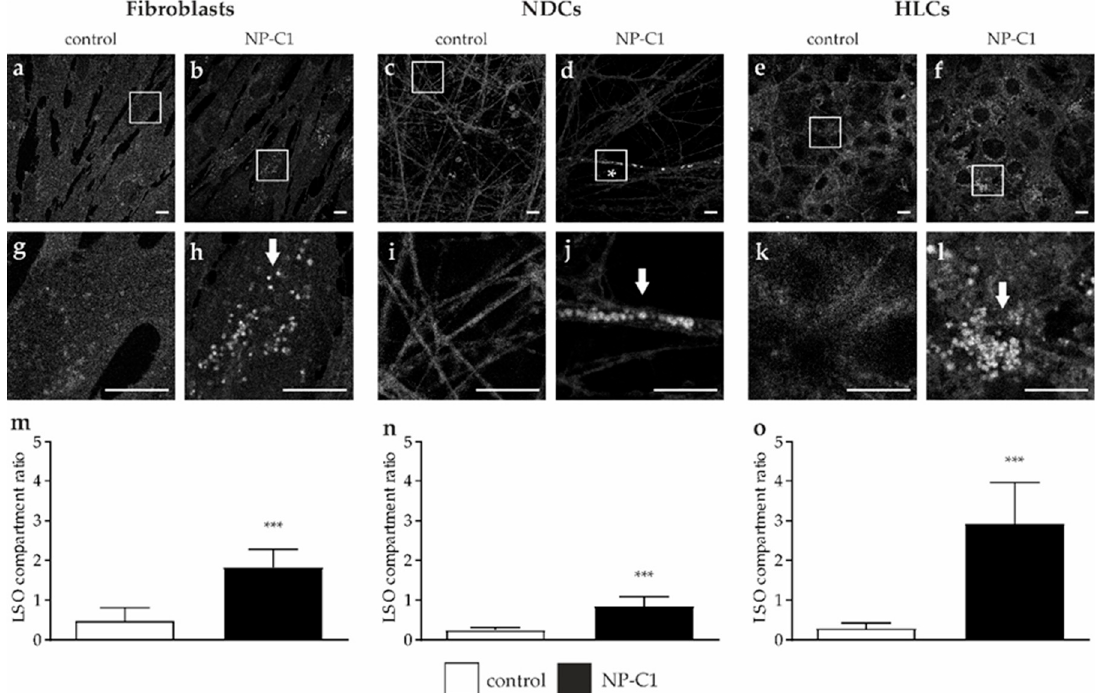
Figure 4. Determination of cholesterol level. Filipin staining was used for a qualitative analysis of cholesterol accumula- tions in fibroblasts ( a , b ), neural-differentiated cells (NDCs, c , d ), and hepatocyte-like cells (HLCs, e , f ). Magnified images of the squared region of each image are shown below ( g – l ). LSO compartment ratio was used to quantify the cholesterol accumulation and revealed a significantly increased ratio in fibroblasts ( m ), NDCs ( n ), and HLCs ( o ). Scale bar = 10 µm. *** = p < 0.001.